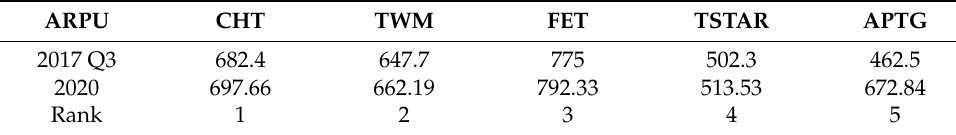
Table 5. The average revenue per user (ARPU) of the mobile operators.